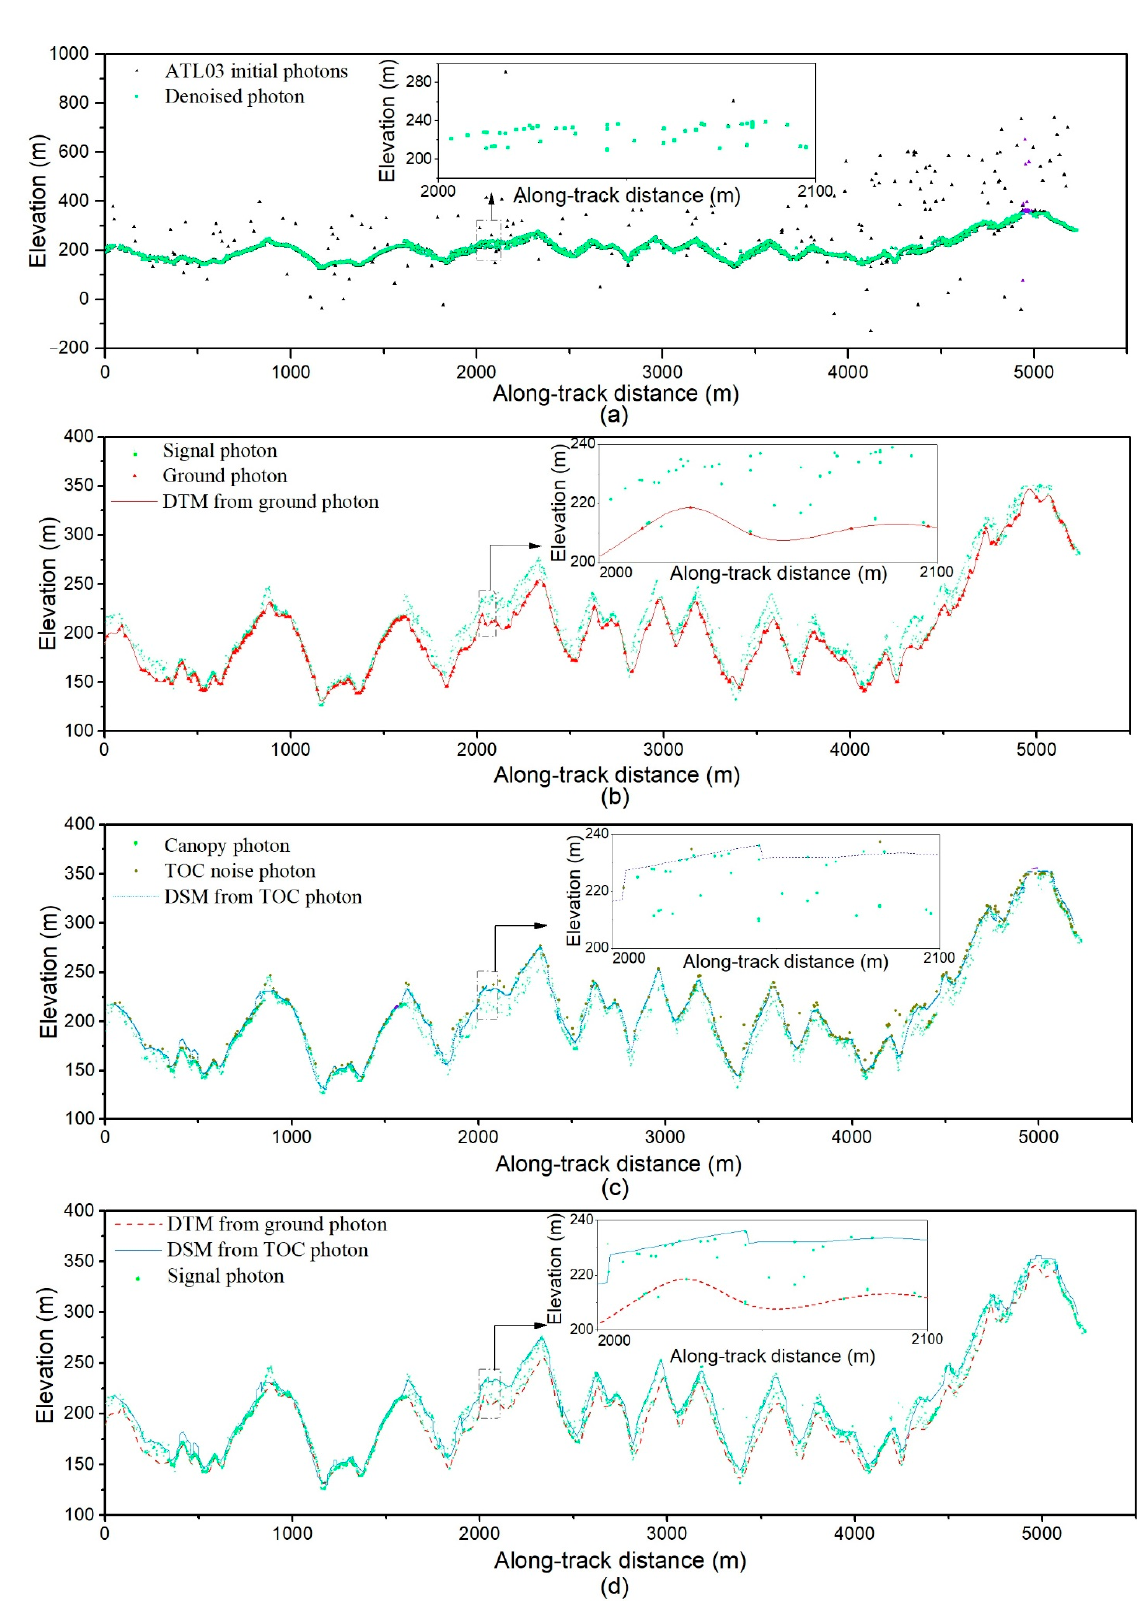
Figure 5. Photon denoising and classification results: ( a ) result of photon denoising; ( b ) result of ground photon extraction and ground surface fitting; ( c ) photon extraction and surface fitting of vegetation canopy; ( d ) DTM and DSM generated by cubic spline interpolation.